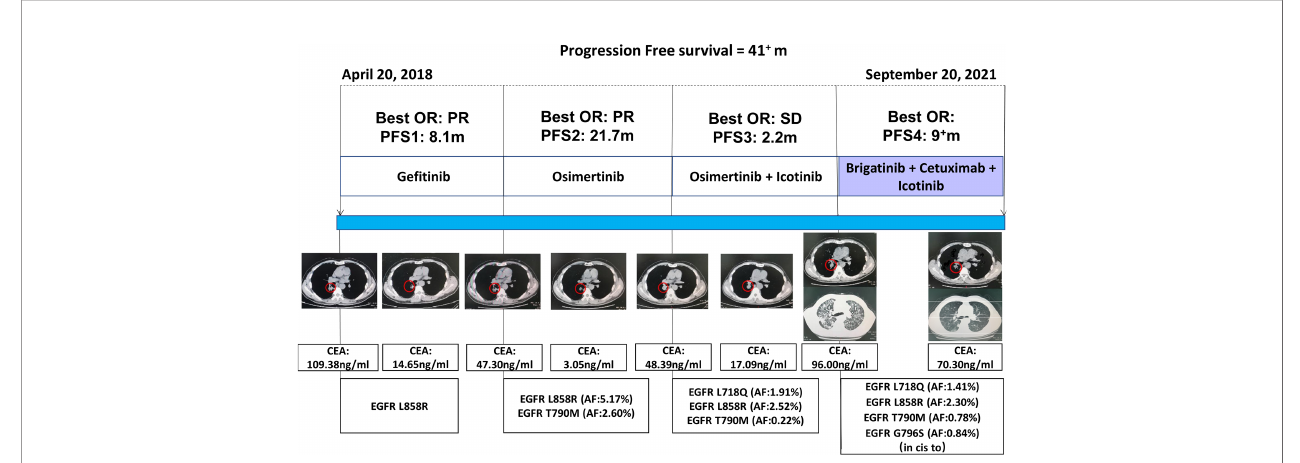
FIGURE 1 | The therapeutic regimens received, the associated best objective response (OR), progression-free survival (PFS), the CEA for each line of therapy, and the major mutations detected. PR indicates a partial response. SD indicates stable